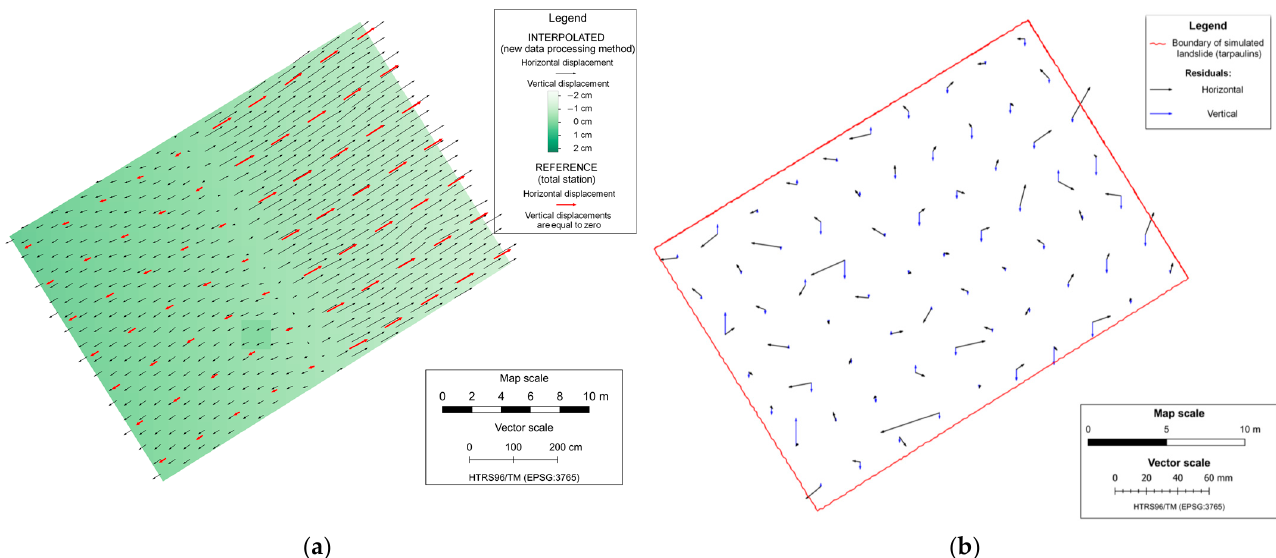
Figure 10. Displacement map of simulated landslide ( a ) and residuals in the first mission ( b ).